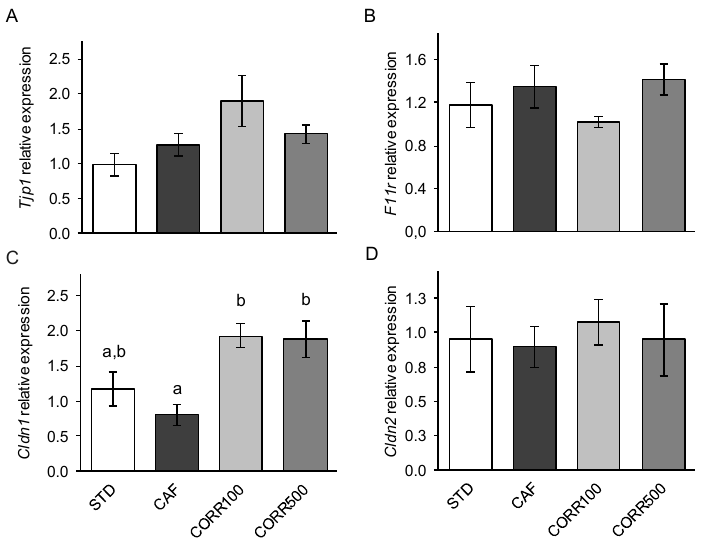
Figure 4. The effect of the GSPE treatment on tight juntion-related gene expression in the ileum of diet-induced obese rats. The expression of target genes was normalized to cyclophilin A gene expression ( Ppia ). Values represent mean ± SEM; n = 8–10. Different letters indicate statistically significant differences between groups ( p < 0.05); ANOVA test followed by Tukey’s HSD test.